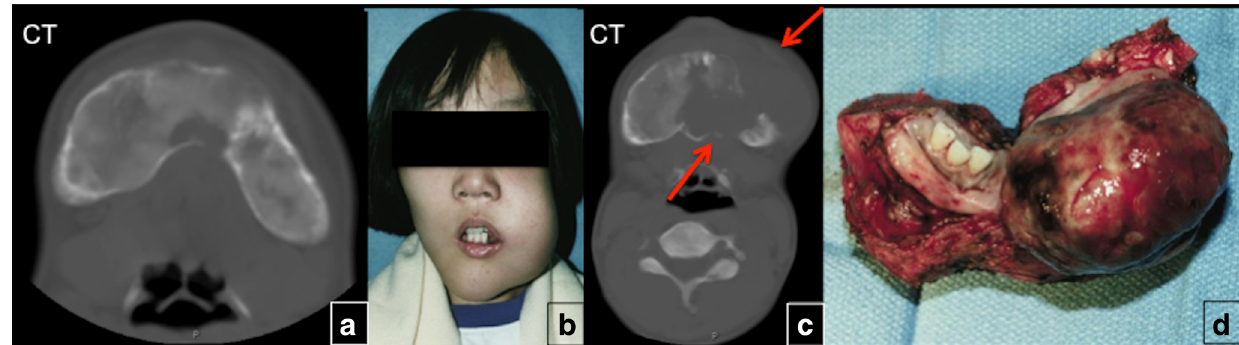
Fig. 18 Malignant transformation of the fibrous dysplasia (FD) lesion. A patient with known craniofacial FD ( a ) presented with enlarging left jaw mass ( b ). CT of the facial bones demonstrated an aggressive lytic lesion